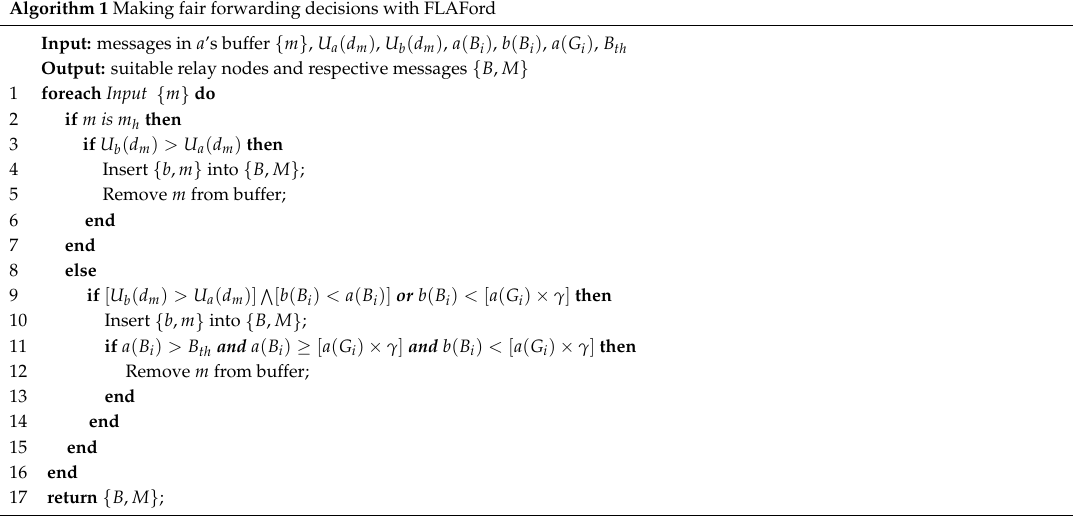
Algorithm 1 Making fair forwarding decisions with